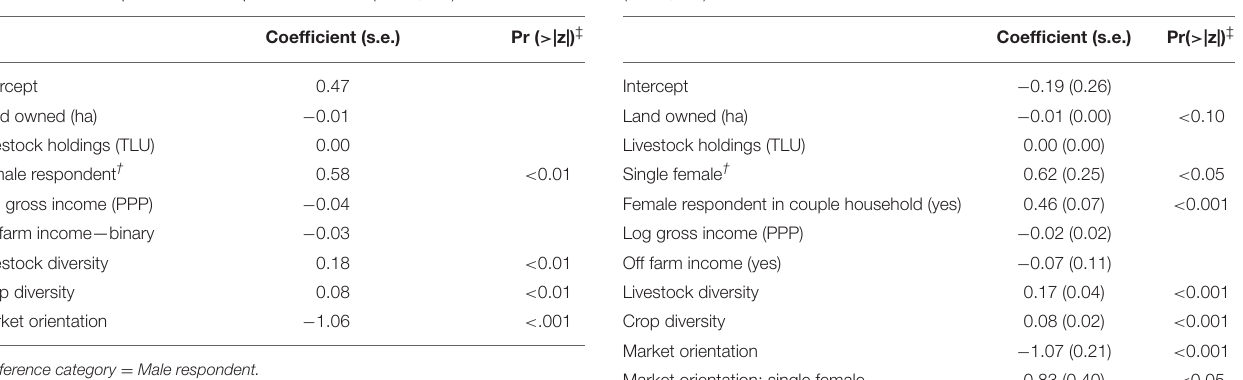
TABLE 7 | Model 2: Binomial regression on female control—All households ( n = 2,859).